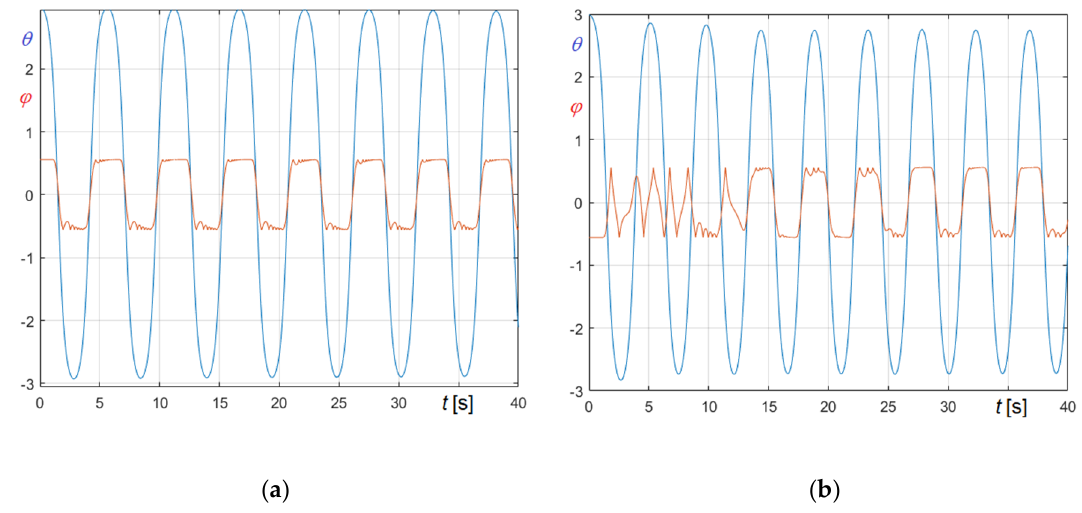
Figure 13. Undamped free oscillations of St. Mary’s tenor in cases I.a and I.b ( K = 0.8 ) : ( a ) θ = θ ( t ) and ϕ = ϕ ( t ) curves for case I.a; ( b ) ) θ = θ ( t ) and ϕ = ϕ ( t ) curves for case I.b.